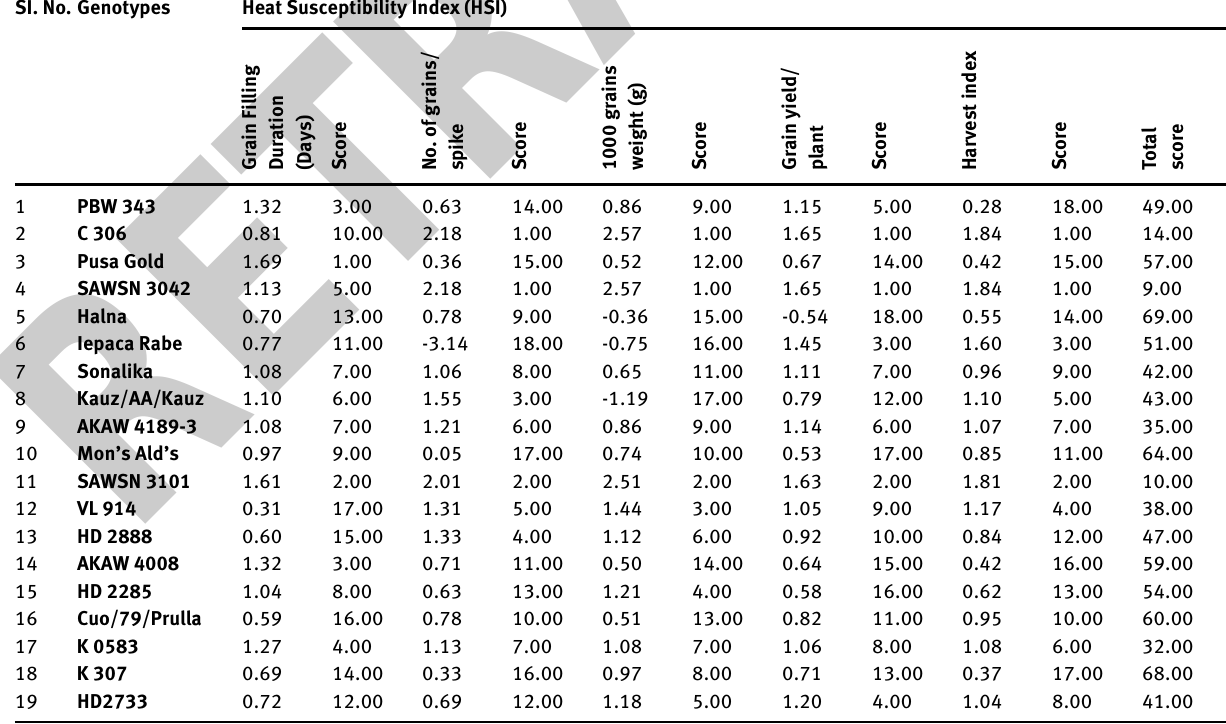
Table 5: Heat susceptibility Index (HSI) of 19 genotypes of wheat (Triticum aestivum L.) for grain filling duration, number of grains per spike, 1000 grain weight, grain yield per plant and harvest index SI. No.